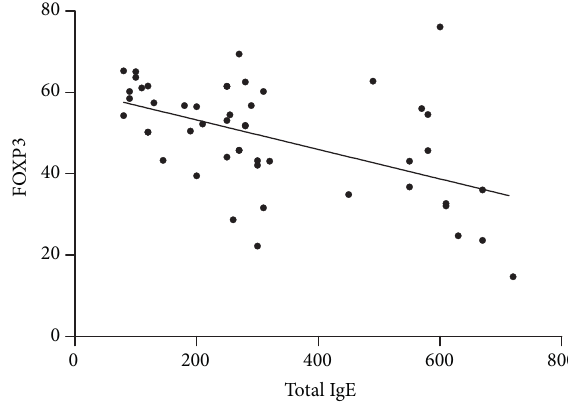
Figure 7: Correlation between FOXP3 and Total IgE.